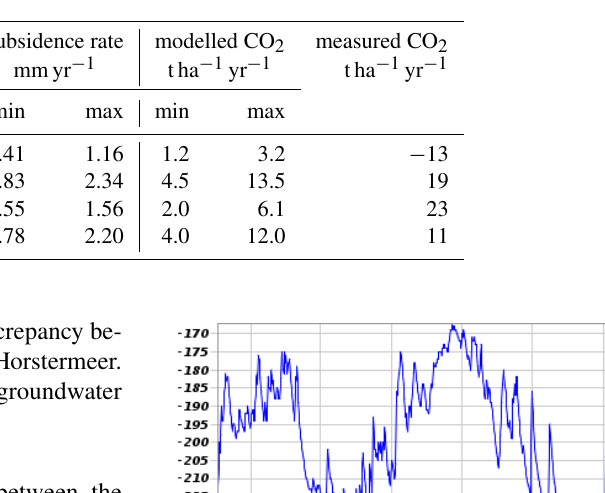
Table 1. Summary of the modelled and measured CO 2 emissions at four locations. Min. and max. values are the results of the min. and max. values of the oxidation fractions and organic matter densities.